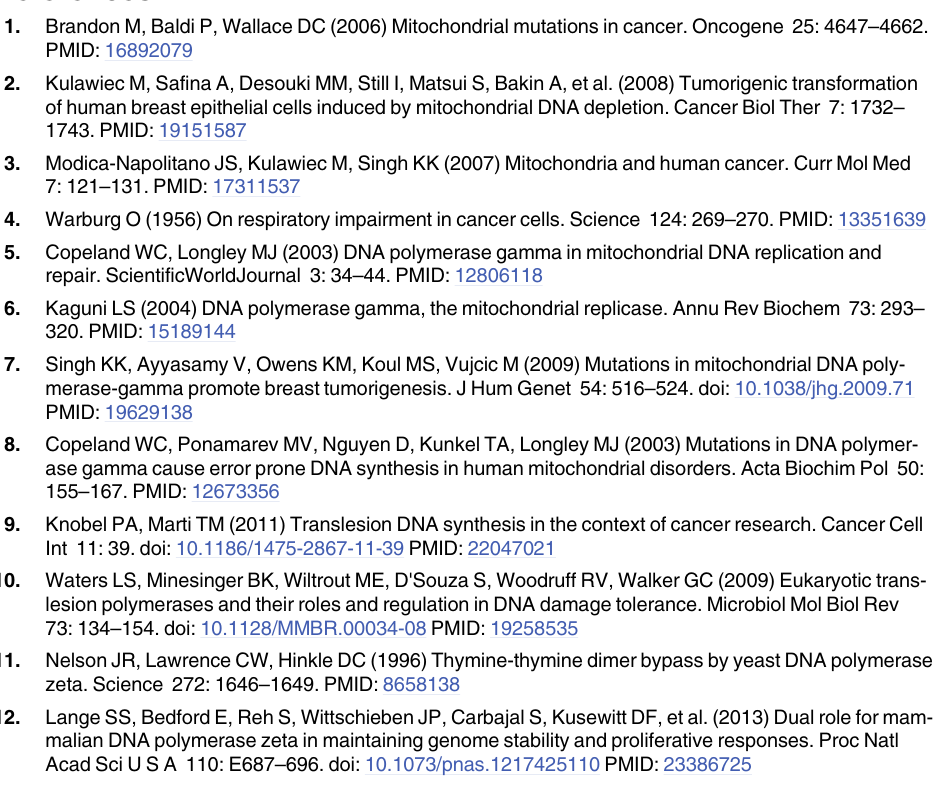
S1 Fig. Immunofluorescence analysis to show the localization of full length REV3 protein in HEK293 cells. A construct containing full length Rev3 and a Flag tag (a gift from Dr. Yoshiki Murakumo) was transfected and anti Flag-M2 antibody was used to detect the localiza- tion of full length REV3 in mitochondria. S2 Fig. ( A ) Western blot with protein samples from REV3 +/+ and REV3 -/- cells to show the specificity of REV3 antibody (Santa Cruz Biotechnology, Cat # sc-48814) used in this study. ( B ) Western blot showing specificity of REV3 antibody (Santa Cruz Biotechnology, Cat # sc- 48814) as well as Rev3 shRNA-mediated knockdown of REV3 in HeLa